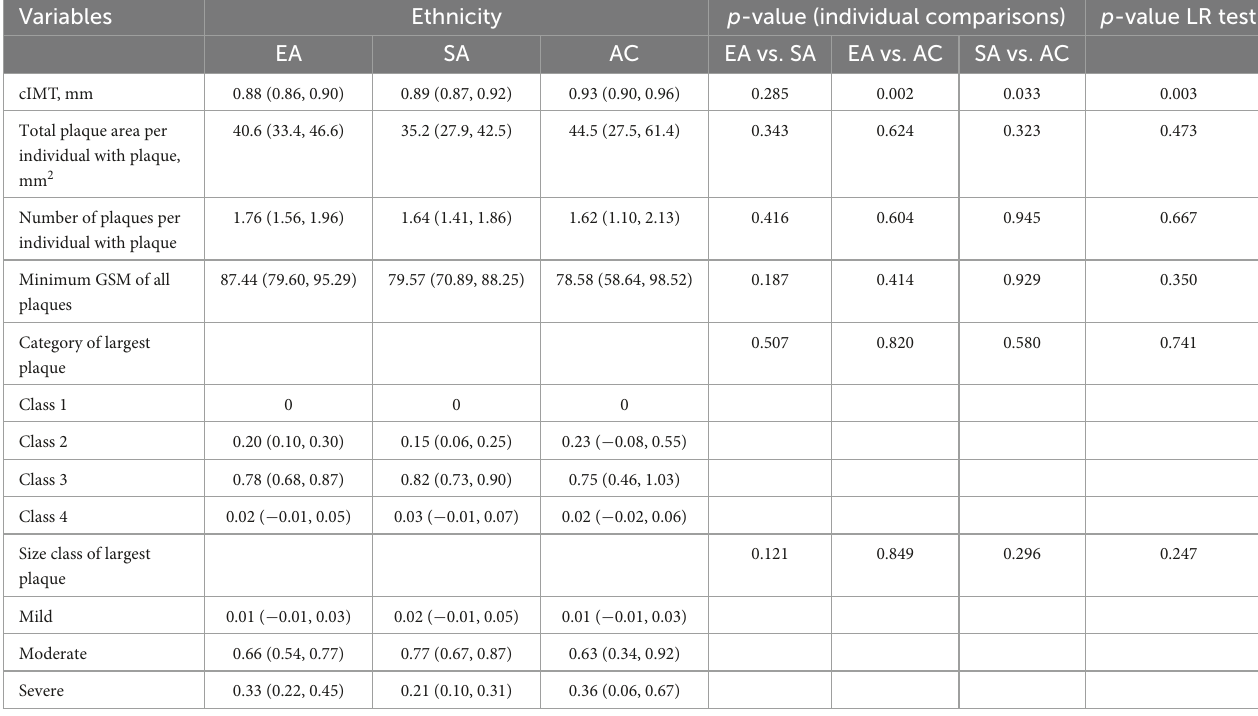
TABLE 3 Ethnic differences in cIMT and plaque characteristics with adjustment for age and sex (Model 1). Variables Ethnicity